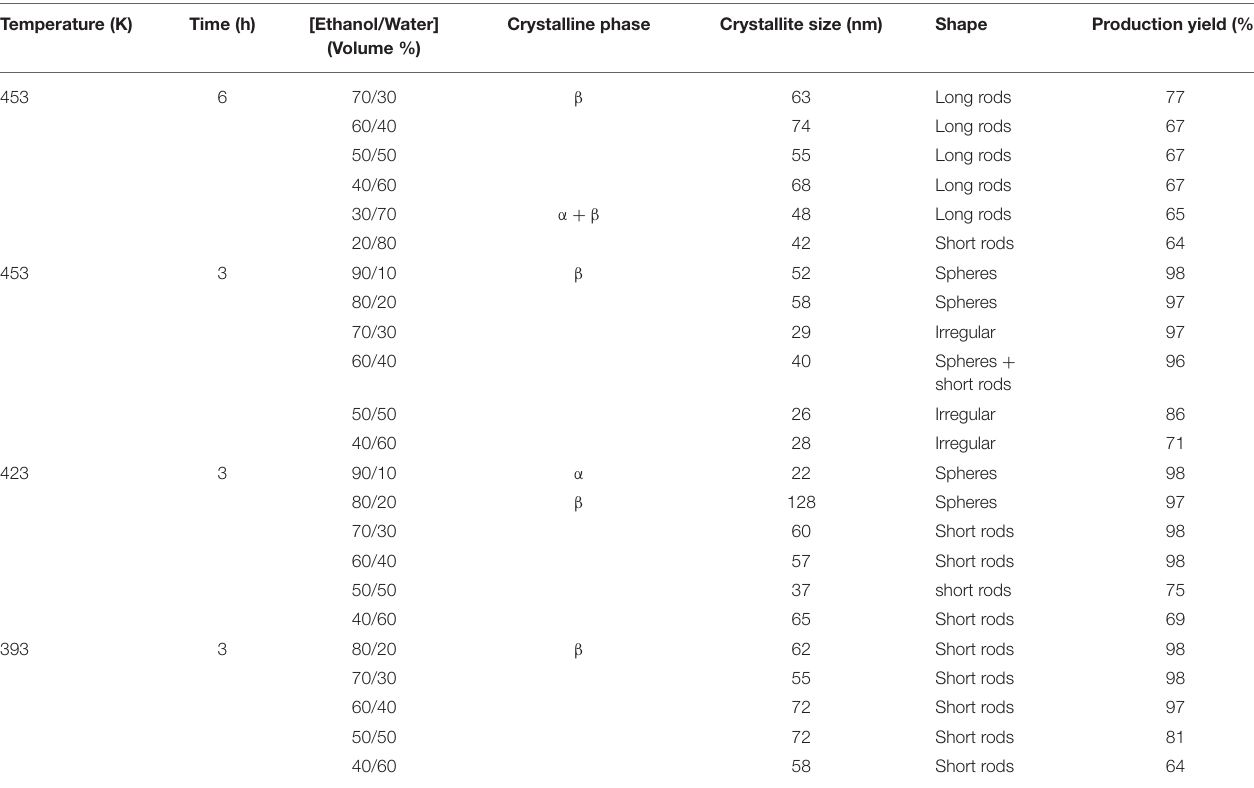
TABLE 1 | Synthesis conditions and main characteristics of the Er,Yb:NaYF 4 nanoparticles obtained by the microwave-assisted solvothermal method. Temperature (K) Time (h) [Ethanol/Water] Crystalline phase Crystallite size (nm) (Volume %)